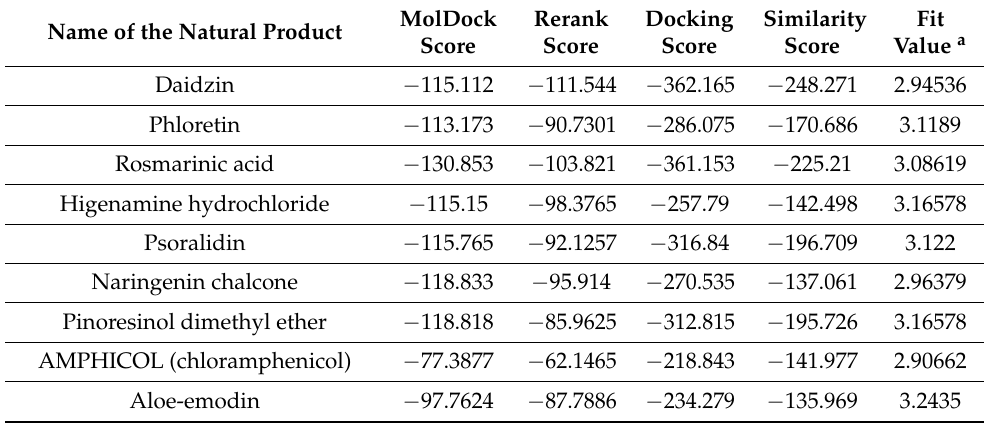
Figure 2. ( A – E ) The ligand pharmacophore mapping of ( A ) daidzin, ( B ) phloretin, ( C ) rosmarinic acid, ( D ) psoralidin, and ( E ) naringenin chalcone. ( F ) The representative figures for the simplified pharmacophore model developed in LUDI for PDB 6LU7. The features extracted by MVD 6.0, the reported pharmacophore model, and the LUDI are the same. The RMSD of 0.032882 Å between the two models also justified this finding. Red, donor; green, acceptor; yellow, hydrophobic features. Table 1. Scores of the MolDock run.